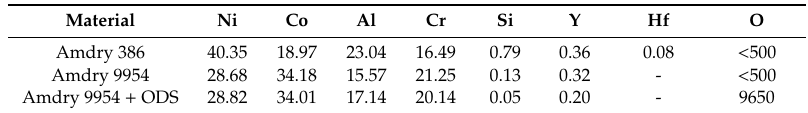
Table 1. Atmospheres and nominal composition of Amdry 386 and oxide dispersion strengthened (ODS) Amdry 9954 in at.-% and O in